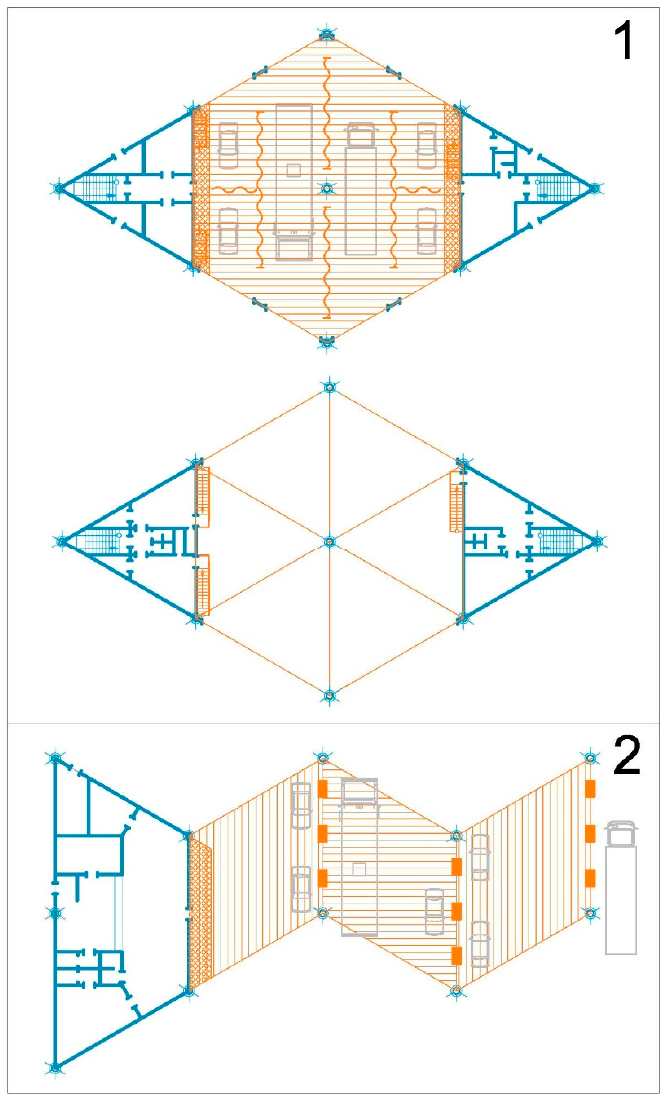
Figure 8. Planning solutions: 1—the Car wash (6 posts)—1st, 2nd floors; 2—the Car refueling (pet- rol-diesel).